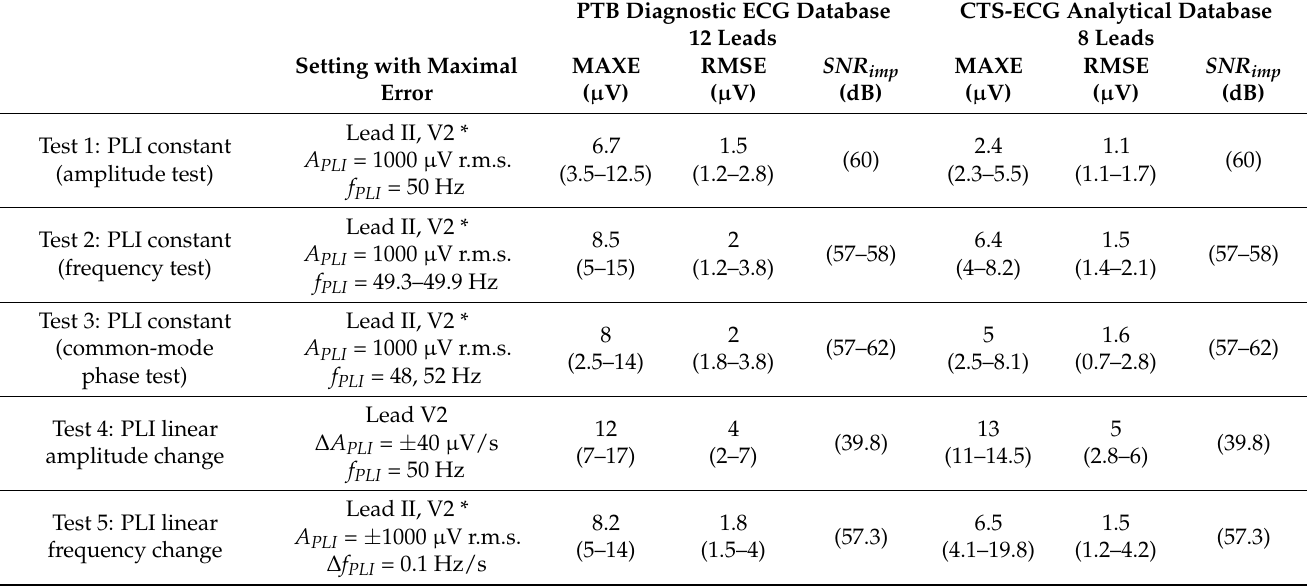
Table 3. Extremity PLI parameters for which SF algorithm fulfils the standard for powerline filers in diagnostic electrocardiographs [41]. Maximal SF errors are reported as median value